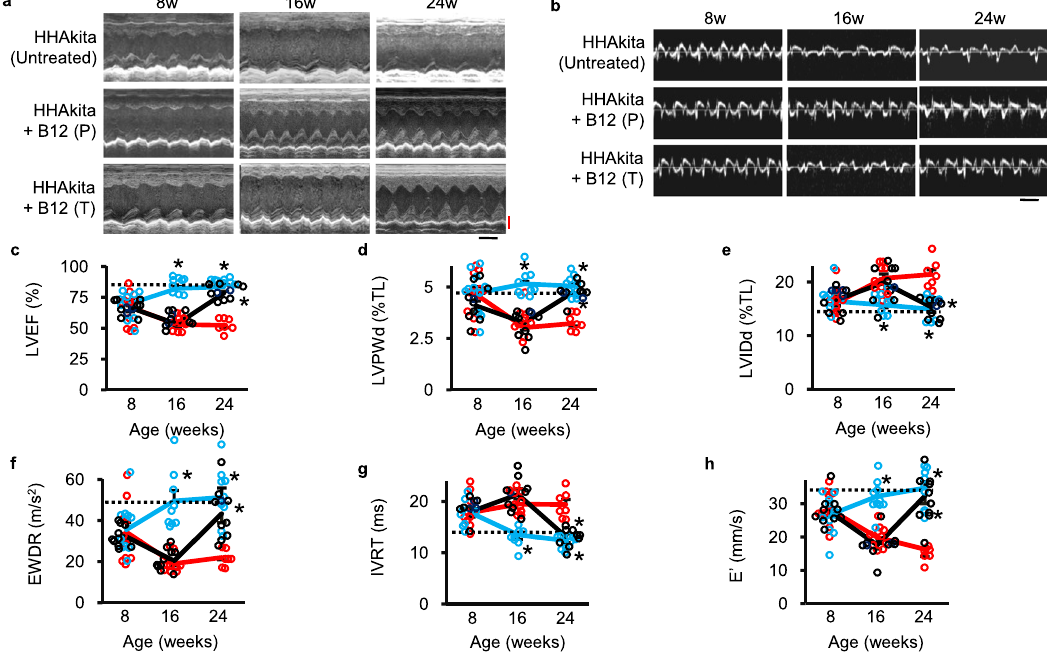
Fig. 2 Prevention and reversal of diabetic cardiomyopathy in the Elmo1H/H Ins2Akita/ + (HHAkita) mice treated with B12 at 10 mg/kg bw/day. a Representative M-mode echocardiograms. Black bar, 0.1 s; Red bar, 0.1 mm. b Representative tissue Doppler imaging. Black bar, 0.1s; Red bar, 50mm/s. c LVEF, d LVPWd, e LVIDd, f EWDR, g IVRT and h E ’ in mice at age 8, 16, and 24 weeks. HHAkita mice were given 10mg/kg bw/day of B12 in the drinking water starting at 8 weeks of age (preventive protocol, B12P; blue lines; N = 9) or starting at 16 weeks of age (therapeutic protocol, B12T; black lines; N = 10). Data are expressed as means± standard errors. The numbers of untreated mice (red lines) were 10 at age 8 and 16 weeks and 7 at age 24 weeks). * P < 0.05 vs. mice with non-supplemented drinking water by Tukey – Kramer Honestly Signi fi cant Differences test. Dotted lines in the fi gures indicate average levels in non-diabetic Elmo1 H/H Ins2 + / +